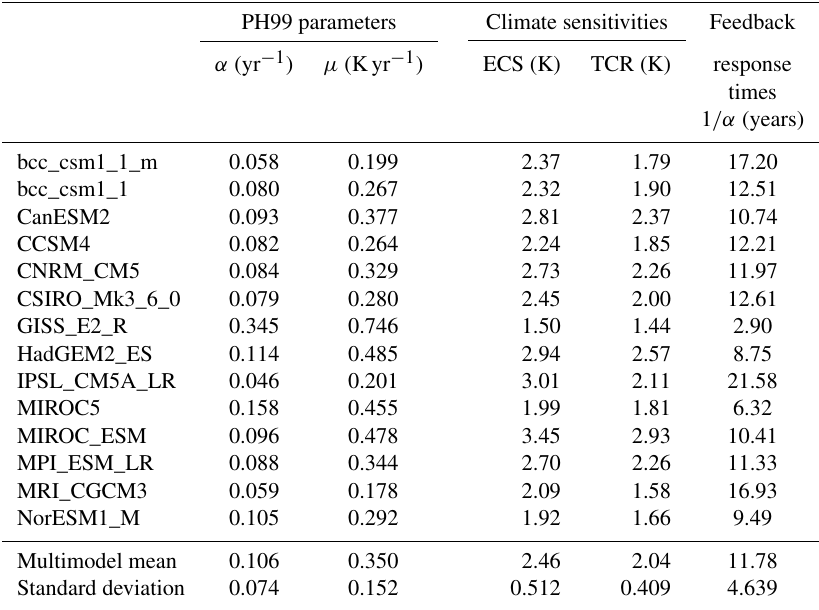
Table 2. PH99 parameters ( α and µ ), climate sensitivities (ECS and TCR), and feedback response times (1 /α ) after fitting PH99 GMT time series to AOGCM RCP2.6 GMT time